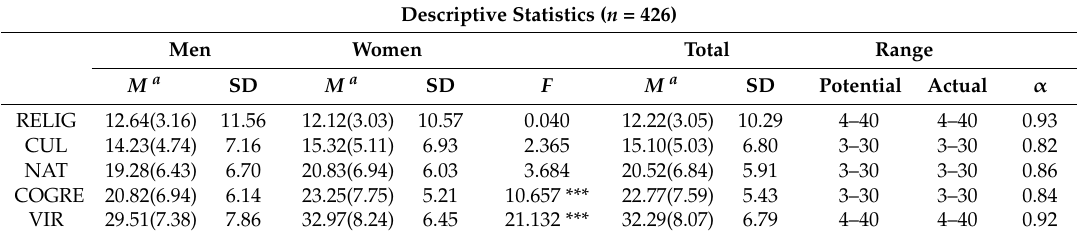
Table 3. Descriptive statistics of sources of spiritual growth, sex differences, and Cronbach’s Alpha of each